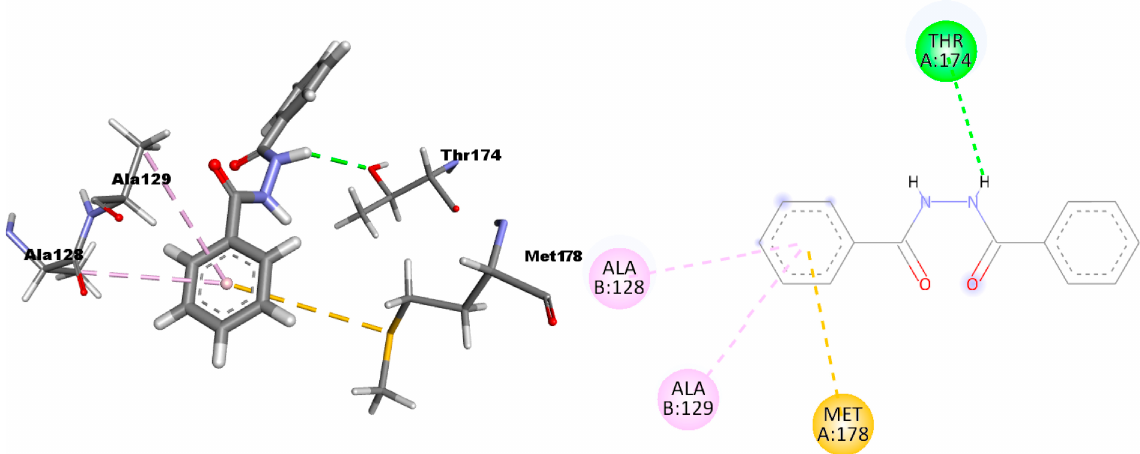
Figure 5. 3D and 2D pictures of the DBH interactions within the HIV integrase receptor.